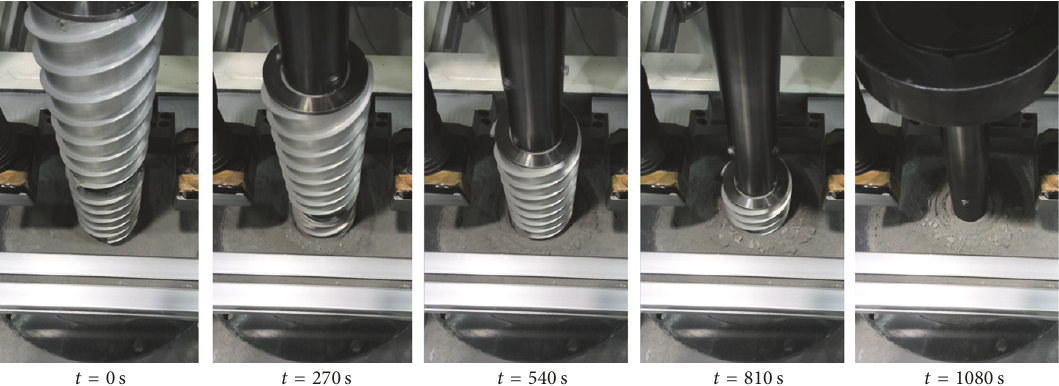
Figure 11: Inchworm drilling experiments process.